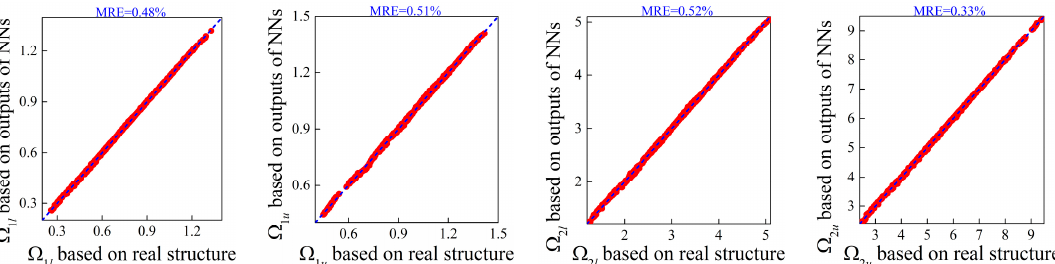
Figure 11. Correlations between the target size-dependent bounding frequencies and those calculated based on the designs output from tandem NNs.